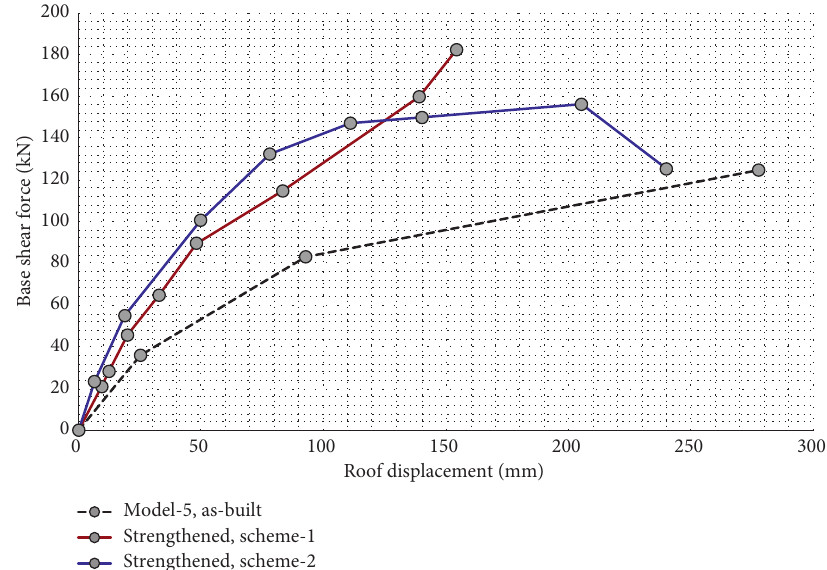
Figure 9: Lateral force-deformation response of as-built and RC haunch retrofitted